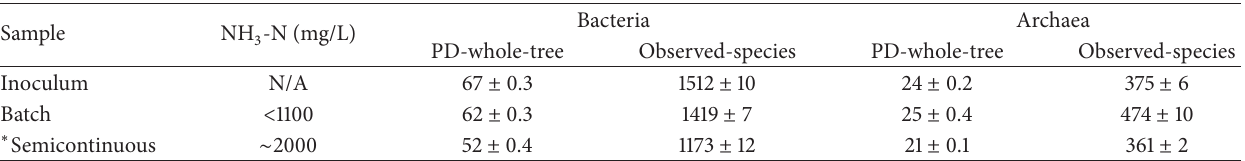
Table 2: Diversity of each sample at different time points during the startup phase of the methanogenic reactor treating swine waste. At the highest NH 3 -N concentration, samples species diversity both for Archaea and for Bacteria was lowest.